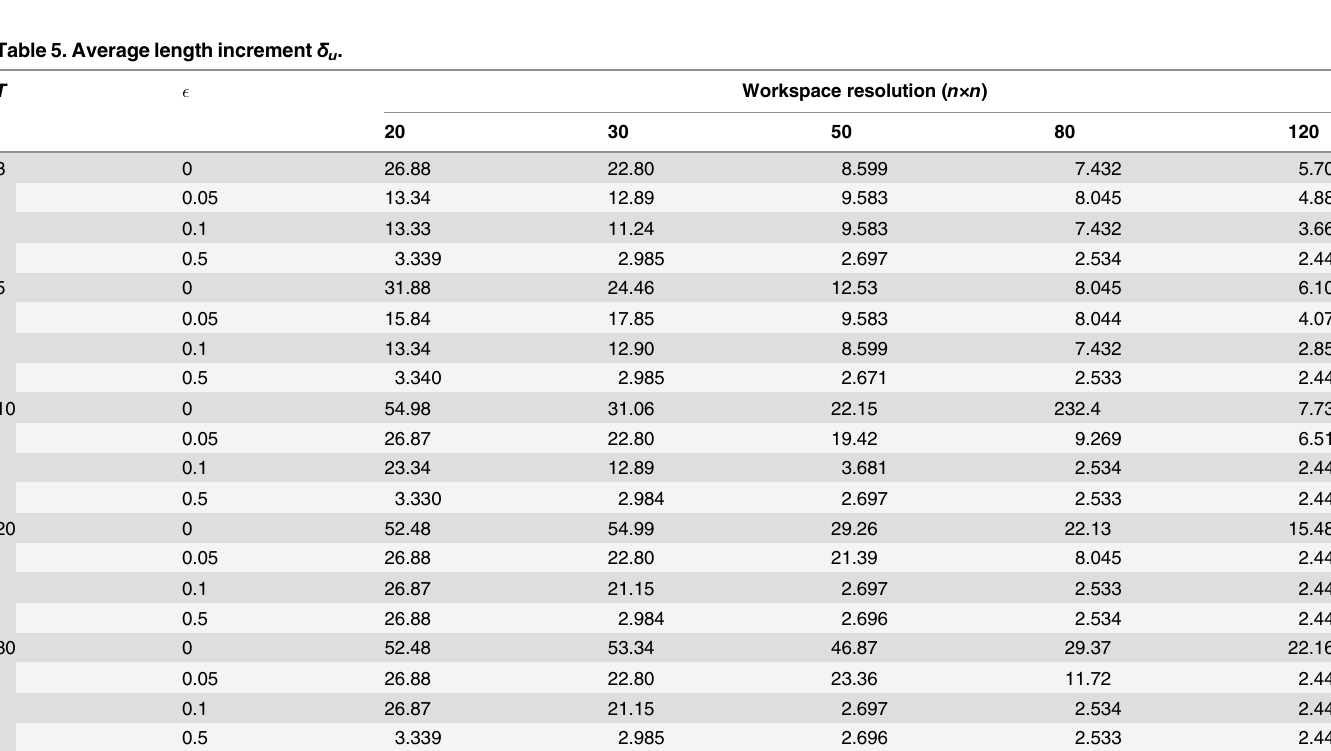
Table 5. Average length increment δ u